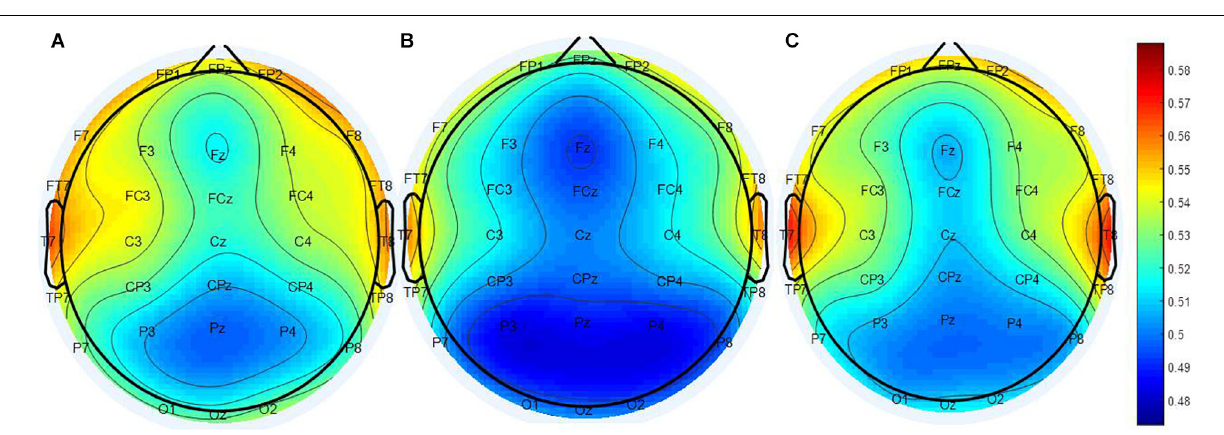
FIGURE 2 | Scalp topographical maps of PEIMF2 index (resting state, eyes closed). From left to right: topographies of the (A) RP, (B) the NR, and (C) HC. PEIMF2 index in RP and HC groups is higher than NR group especially at left frontal